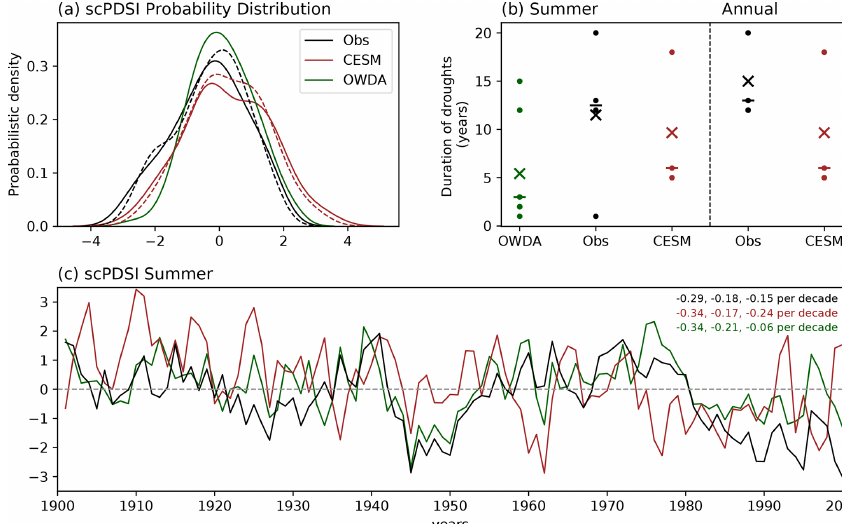
Figure 3. (a) Probabilistic distribution of the yearly self-calibrated Palmer drought severity indices (scPDSIs) from the U.Delaware v5.01 observation (black), CESM (red), and OWDA (green) smoothed by kernel density estimates using Gaussian kernels. Continuous lines indicate the summer, and dashed lines indicate the annual scPDSIs. The t tests are applied among these distribution under the null hypothesis of equal means between two time series.The p value between the summer scPDSI from CESM and OWDA is 0.28, between the OWDA and observation it is 0.01, and between the CESM and observation it is 0.001 for both summer and annual values. (b) Distribution of duration of annual droughts in different datasets. Crosses are the means and horizontal dashes the medians of the duration of droughts. (c) Time series of summer scPDSIs from the observation (black), CESM (red), and OWDA (green) for 1901–2000CE. The numbers on the upper right indicate the values of the trends per decade, from left to right, for the periods 1901–1950CE, 1951–2000CE, and 1901–2000CE. All of these trends are statistically significant at 95% confidence interval based on the Mann–Kendall